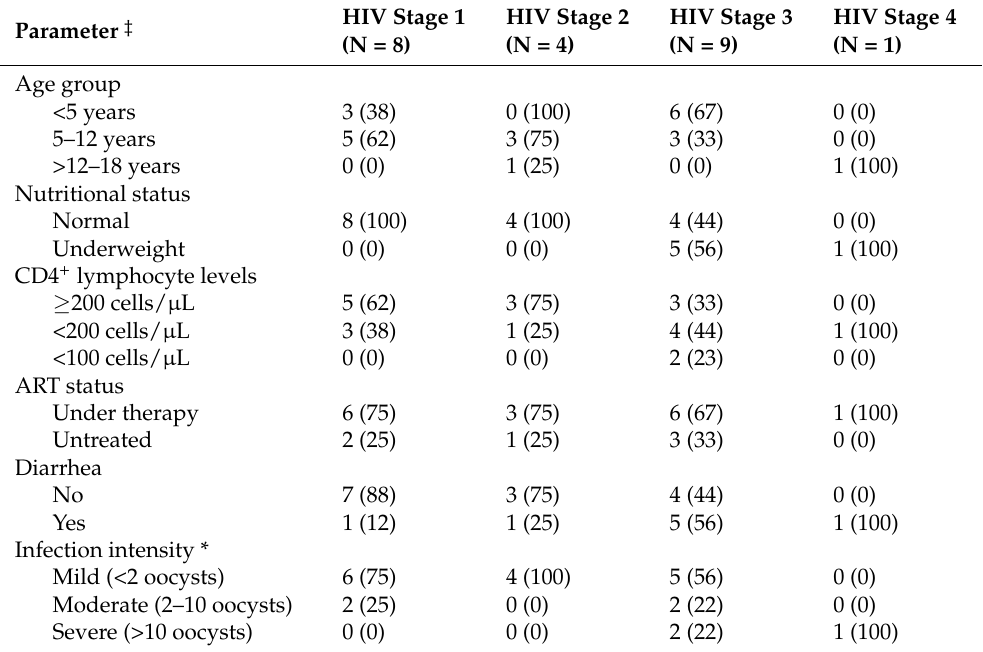
Table 2. Distribution of Cryptosporidium spp. infection in relation to the stages of